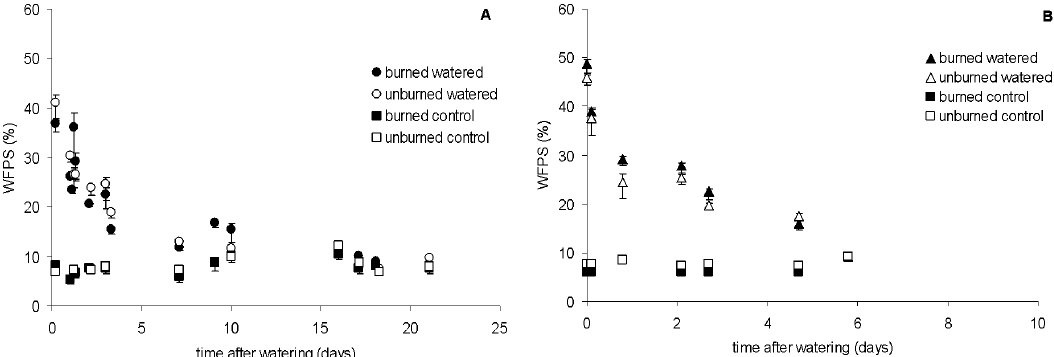
Fig. 1. Soil water filled pore space (%) (0–10cm soil depth) in function of time after watering (days) during the 1st campaign (A) one month after burning and the 2nd campaign (B) eight months after burning. The vertical bars correspond to one standard error ( n = 3 to 12).